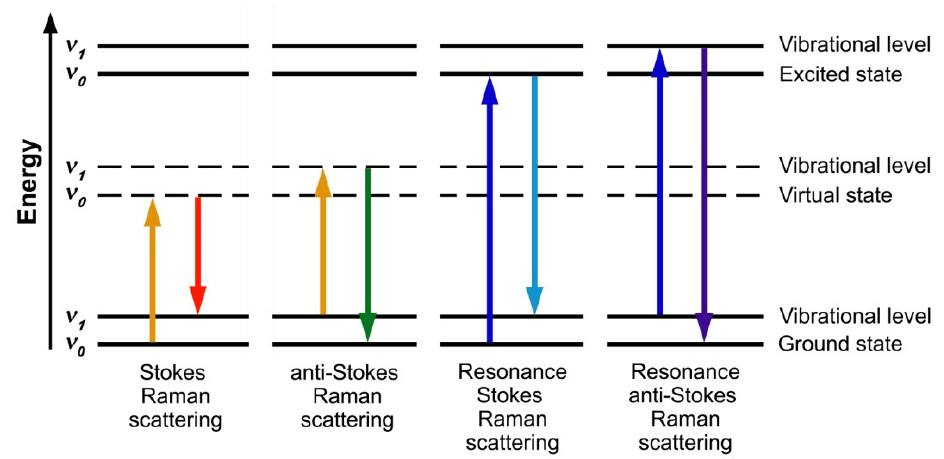
Figure 3. The schematics of Raman scattering processes of photons. The arrows show the transitions between different states, which are labeled; n and m denote the vibrational ground and excited states. Raman spectroscopy was applied to investigate the modified electronic structure of SWCNTs filled with MnCl 2 , MnBr 2 [35,36], FeCl 2 , FeBr 2 , FeI 2 [12], CoBr 2 [13], NiCl 2 ,